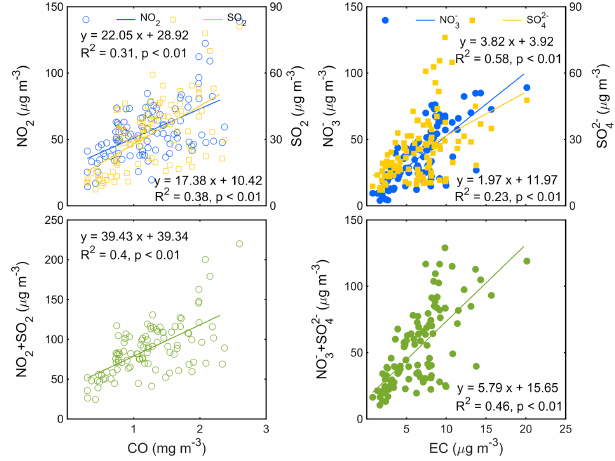
Figure 2. Correlations of carbon monoxide (CO) with nitrogen dioxide (NO 2 ), sulfur dioxide (SO 2 ) and the sum of nitrogen diox- ide and sulfate dioxide (NO 2 + SO 2 ) in ambient air, and correlations of EC with nitrate (NO − ), sulfate (SO 2 − ) and the sum of nitrate 3 4 + SO 2 − and sulfate (NO − ) in PM 2 . 5 from 14 to 29 January 2015 in 3 4